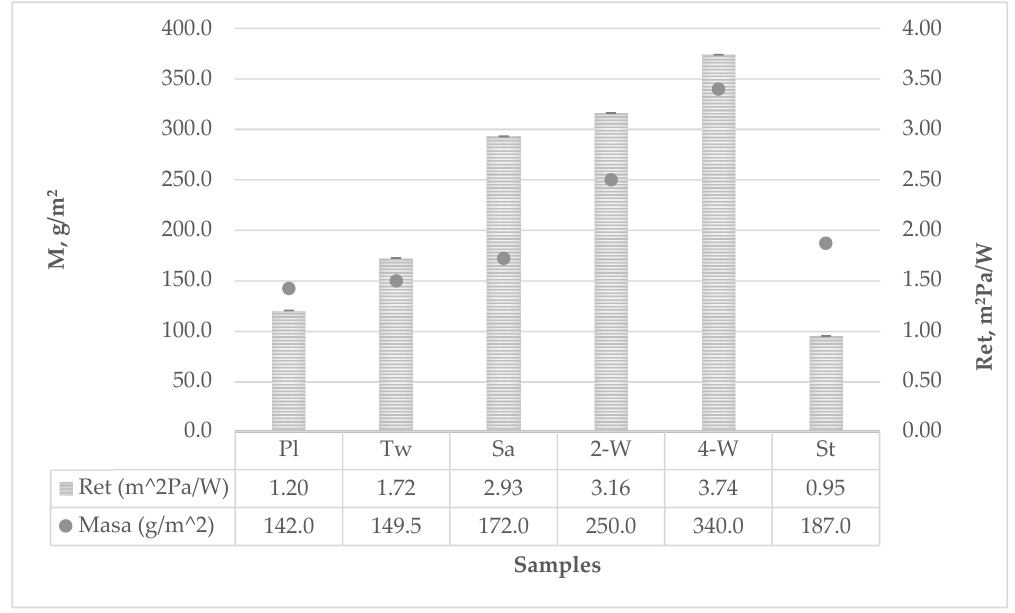
Figure 2. Water vapor resistance diagram.